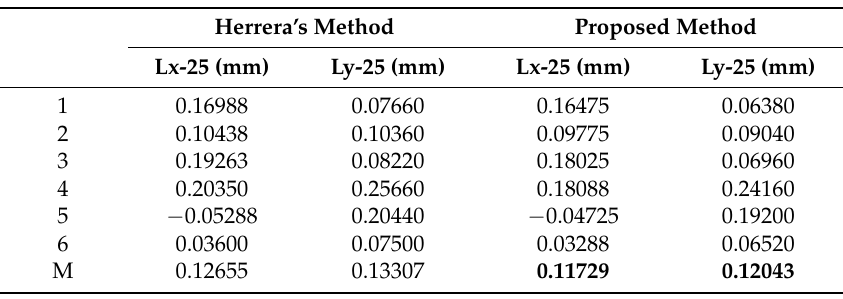
Table 5. Distance errors between the reconstructed